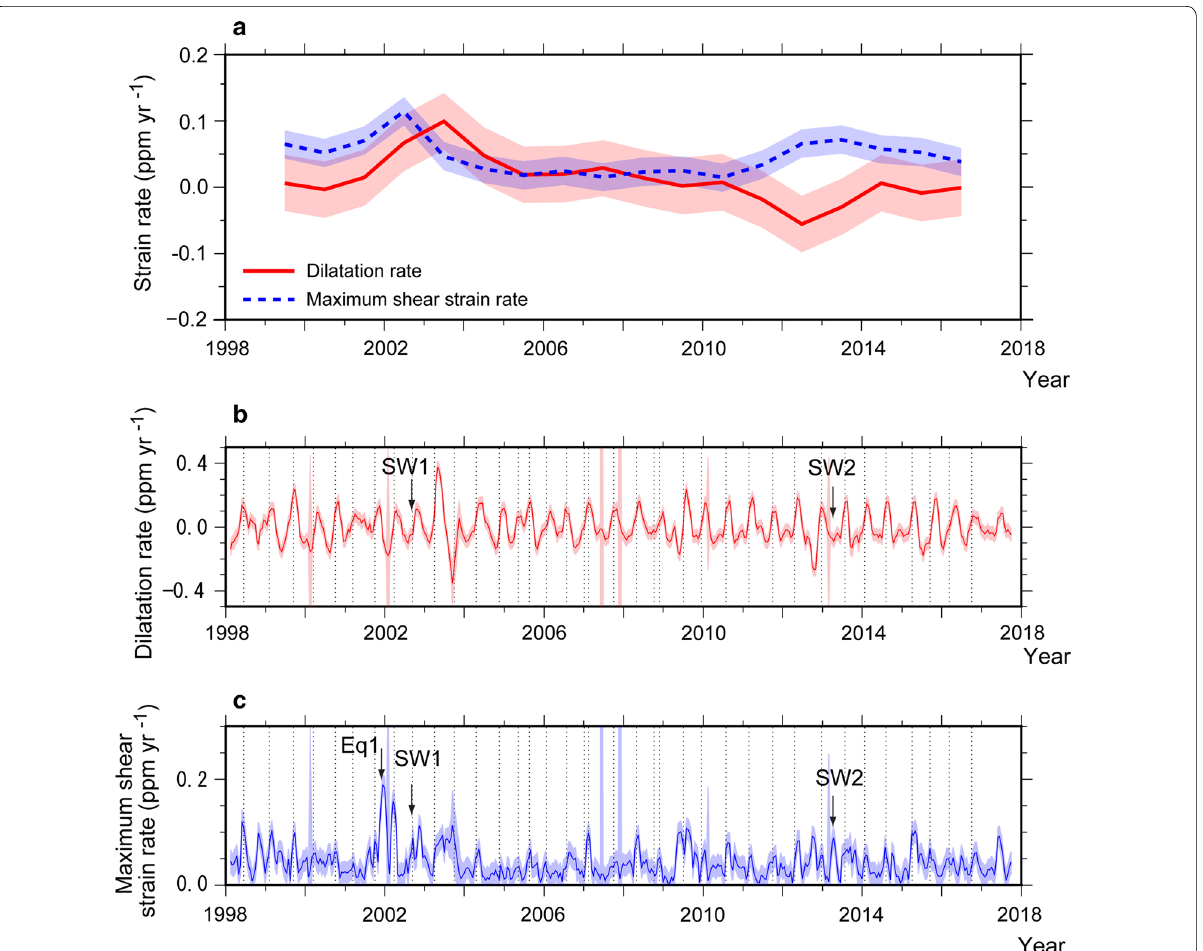
Fig. 5 Strain rate change in the Yaeyama Islands. a Averaged strain rate for 3 years in the Yaeyama Islands from 1999 to 2016. Red line and dotted blue line show the dilatation rate and maximum shear strain rate, respectively. Thin red and blue areas show the error range of the dilatation rate and maximum shear strain rate, respectively. b Averaged dilatation rate for 3 months in the Yaeyama Islands from 1998 to 2017. Red line shows the dilatation rate. The thin red area shows the error range of the dilatation rate. Dotted vertical lines show the occurrence of the SSEs by Tu and Heki (2017). c The same as b but for the maximum shear strain